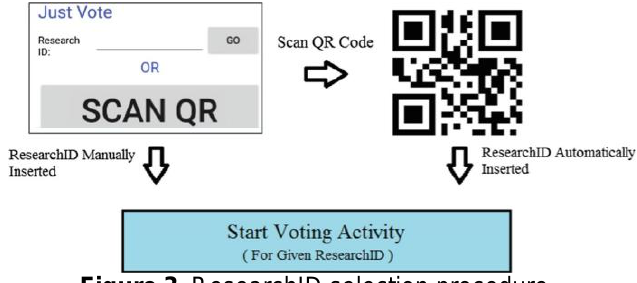
Figure 3. ResearchID selection